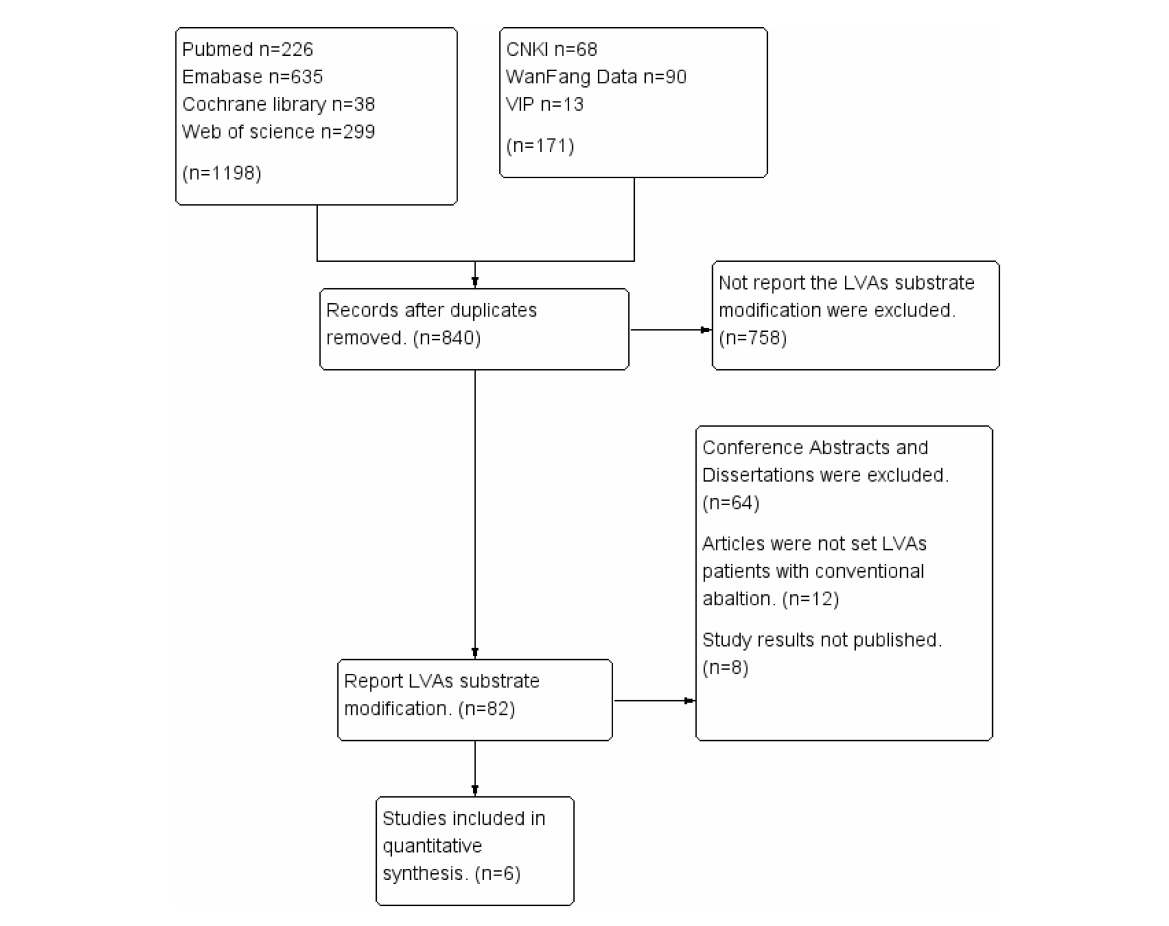
FIGURE1 Study selection